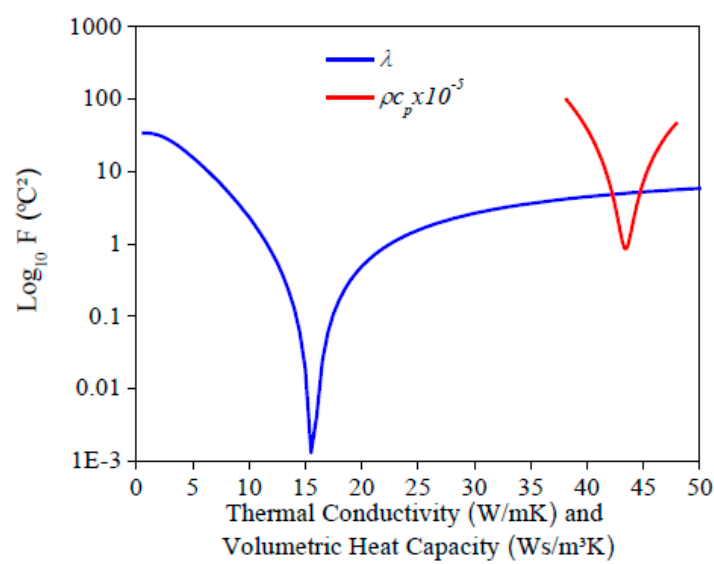
Figure 10. Sensitivity coefficient of the AISI 304 stainless steel sample.